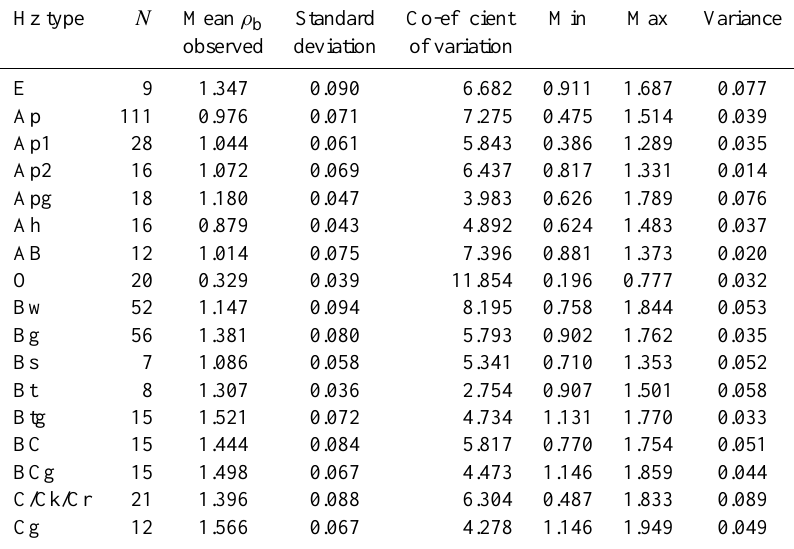
Table 3. Statistics of observed bulk density, ρ b (gcm − 3 ) for each horizon type, used in the development of pedotransfer